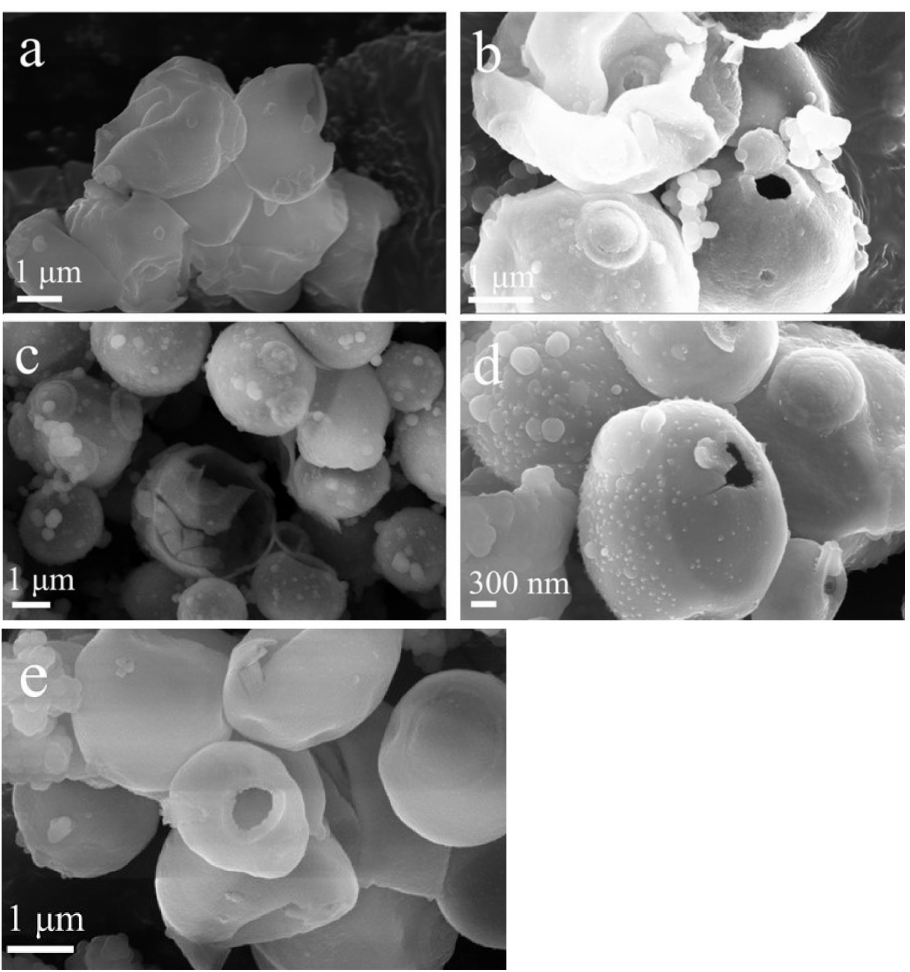
Figure 4. SEM images of SiO 2 synthesized at different aging times: ( a ) 6 h; ( b ) 10 h; ( c ) 12 h; ( d ) 24 h; ( e ) 36